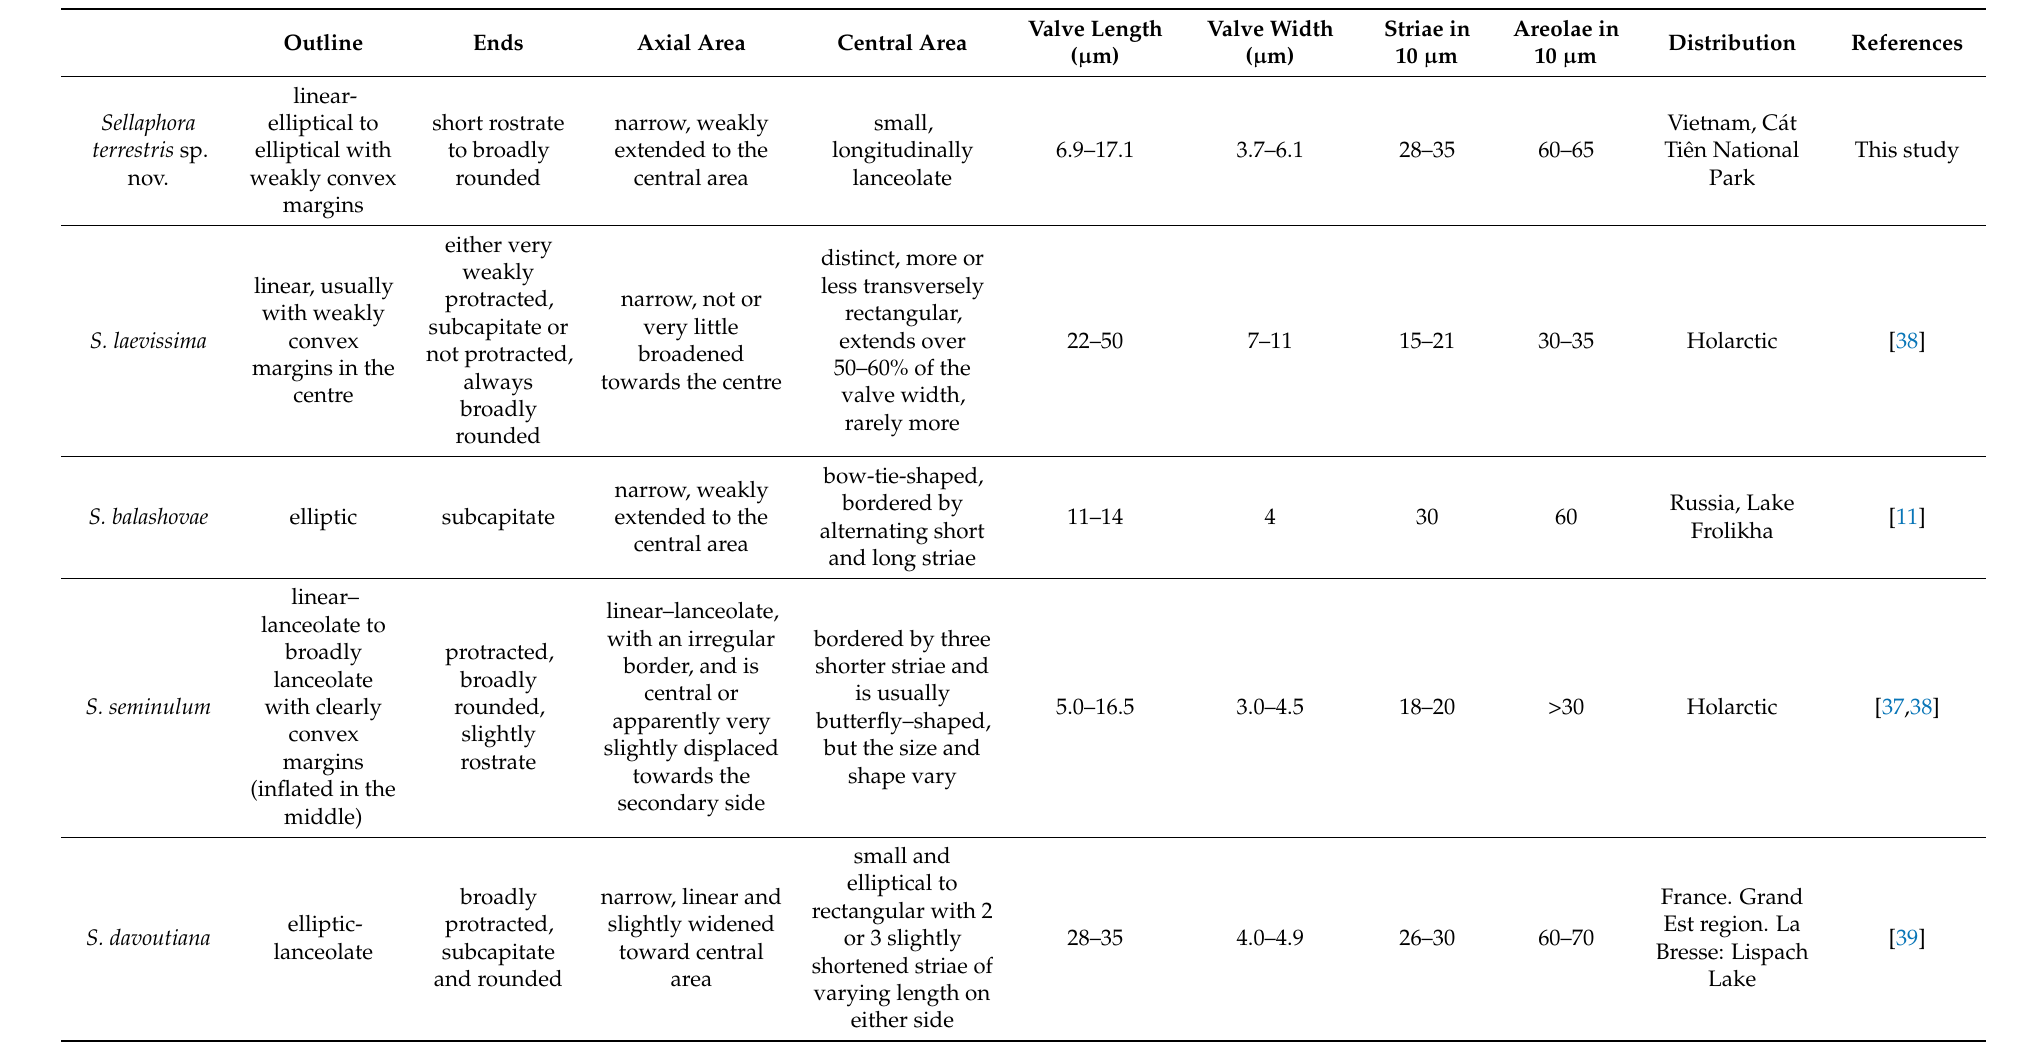
Table 3. Comparison of Sellaphora terrestris sp. nov. with similar species of Sellaphor a and Microcostatus